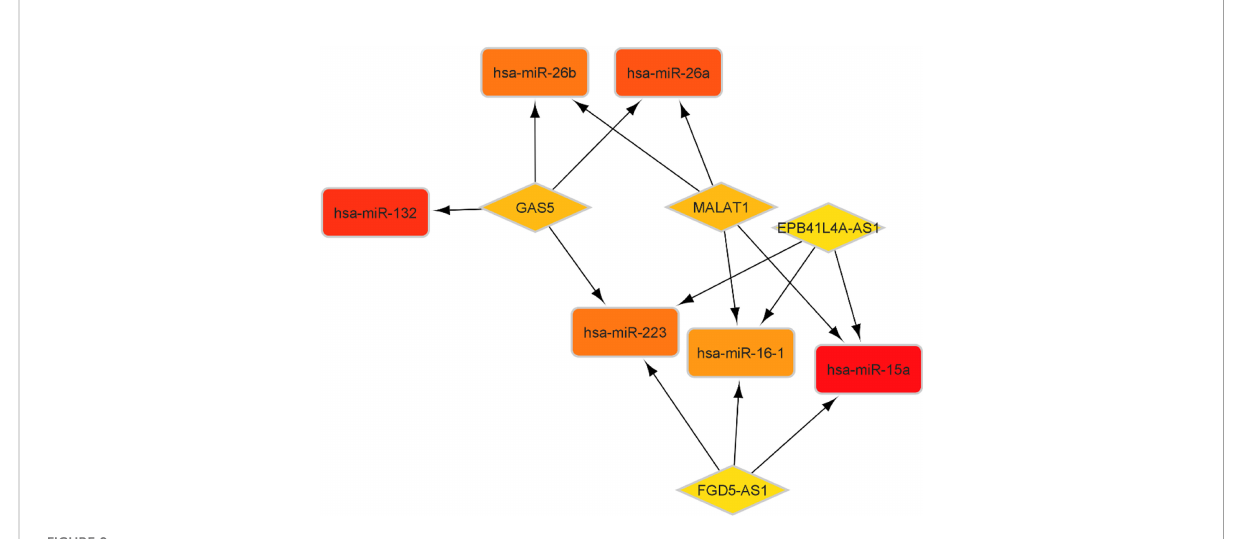
FIGURE 9 Top 10 genes with best degree in ceRNA